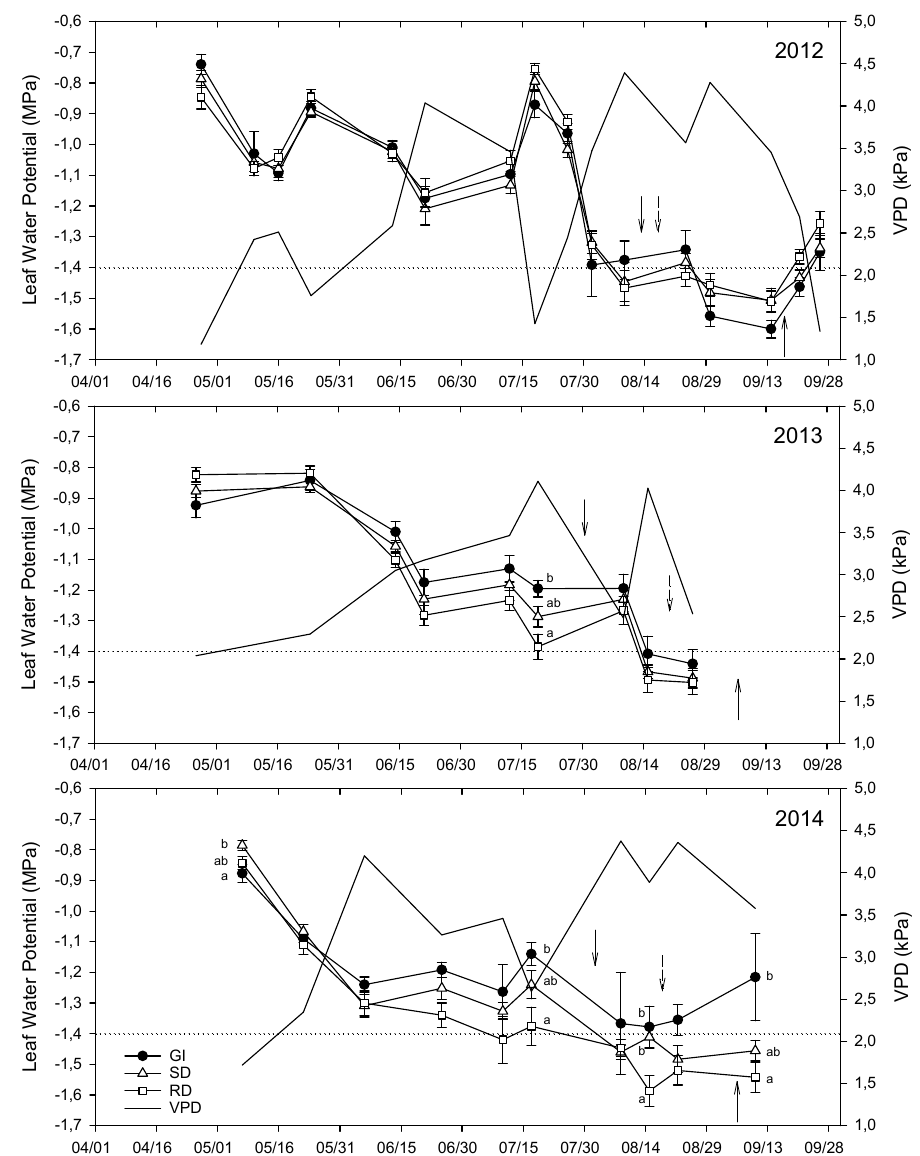
Figure 3. Leaf water potential for 2012, 2013, and 2014 for grower irrigation (GI), sustained deficit (SD) and regulated deficit (RD) vapor pressure deficit (VPD). The down arrow represents irrigation withhold start point. The dotted shape arrow down represents the date when the canes were cut. The arrow up represents the restoration of the irrigation after harvest. Each value is the mean ± SE of six individual measurements. Different letters at each time indicates significant differences according to the Tukey’s Test HSD ( p ≤ 0.05).